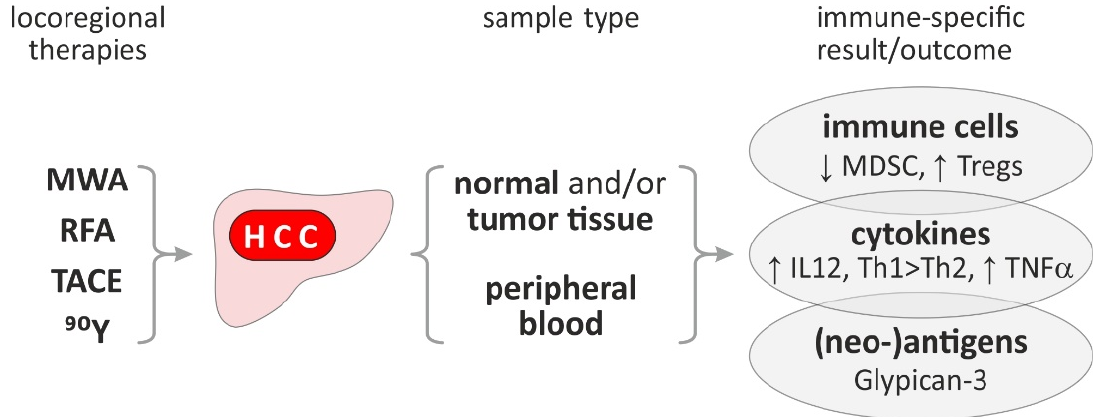
Figure 3. Overview of known immune effects of locoregional therapies for HCC. The arrows indicate the up- or downregulation of the observed immune effects. Based on [48–56]. Abbreviations: 90 Y, XYZ; HCC, hepatocellular carcinoma; IL, interleukin; MDSC, myeloid-derived suppressor cells; MWA, microwave ablation; RFA, radiofrequency ablation; TACE, transarterial chemoembolisation; TNF, tumor necrosis factor; Treg, regulatory T cell.